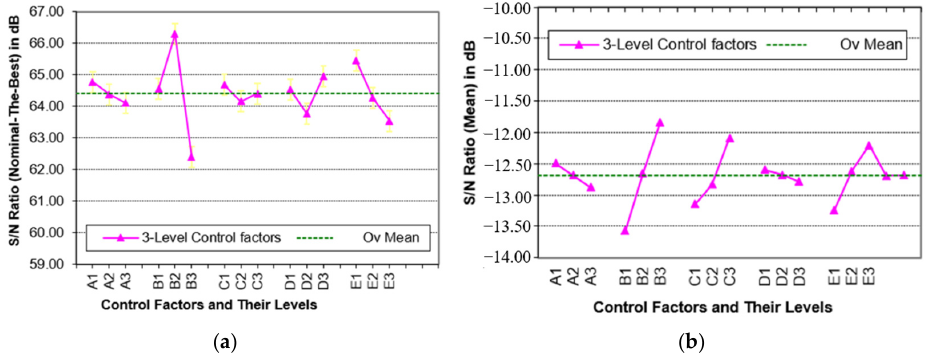
Figure 5. ( a ) Factor effects plot of (S/N) NTB for V th ; ( b ) factor effects plot of (S/N) Mean for V th . S/N ratios were calculated for each factor and level; they were tabulated as shown in